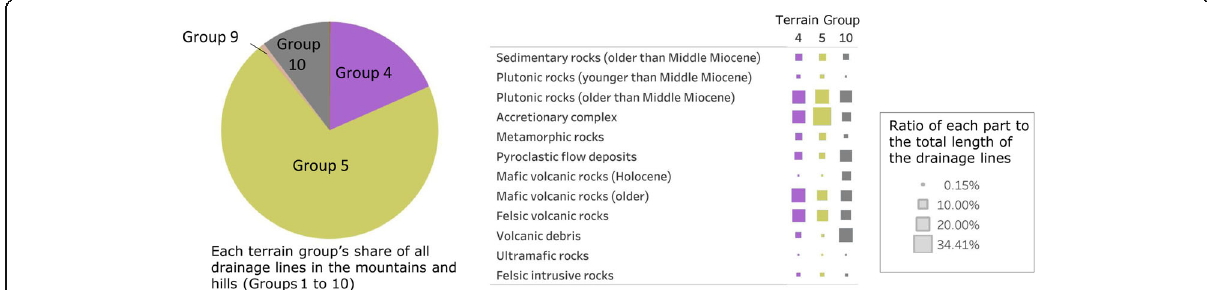
Fig. 12 Length of the drainage lines for mountains and hills in Honshu Island with their geology. The drainage lines were extracted from the 30 m DEM and the same ones used to calculate HAND. The geological units found in the mountains (SEGM) were used for the